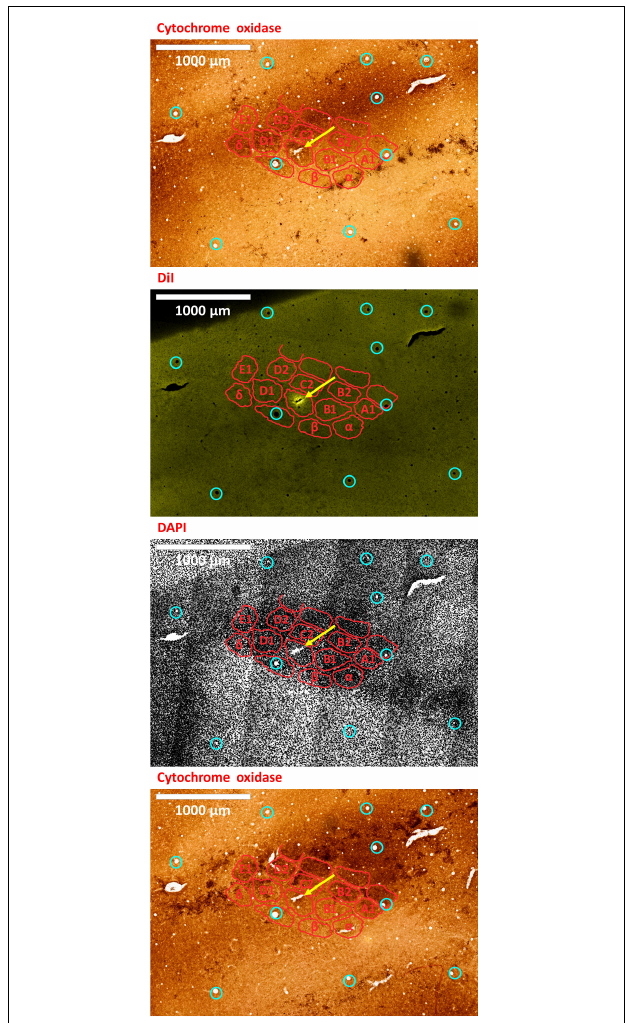
FIGURE 7 | An electrode insertion into a pre-defined barrel is verified by DiI fluorescence co-localized with DAPI and cytochrome oxidase staining of the flattened cortex. Post-experiment histology was performed on the flattened cortex of the mouse’s right hemisphere, from which we present three consecutive slices. In all panels, red perimeters delineate the major barrels, as identified by cytochrome oxidase and DAPI, and yellow arrows point to the insertion within the targeted barrel. Penetrating blood vessels (marked with cyan circles) were used to optimize the finescale registration of the three adjacent slices using translation and rotation (see Shmuel et al., 2005). The top-most and bottom-most panels present brightfield images of cytochrome oxidase staining of the first and third slices, respectively, showing the targeted C1 barrel. The second and third panels represent the same second slice imaged using different filters; therefore, corresponding pixels are perfectly co-aligned between them. The second panel shows the electrode insertion site, imaged using a TRITC filter at 580 nm. The recording electrode was coated with DiI prior to insertion; thus, the DiI fluorescence image identifies the insertion site (yellow arrow). Twelve penetrating blood vessels (marked with cyan circles) were used to optimize the registration of consecutive slices using translation and rotation (see Shmuel et al., 2005). The DiI mark of the insertion site in the second panel shows that the insertion was inside the targeted C1 barrel in the top and bottom panels. The third panel shows the DAPI counterstaining of cell bodies’ nuclei of the same slice, performed using a DAPI filter (distribution of wavelengths centered on 455 nm). A grayscale filter was applied to the DAPI image in order to improve visualization of the barrel field. The scale bar represents 1